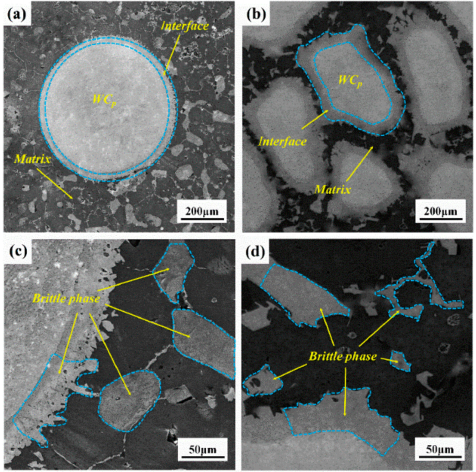
Figure 3. The metallographic photographs of composites with different particle shape: spherical particle ( a , c ), and irregular particle ( b , d